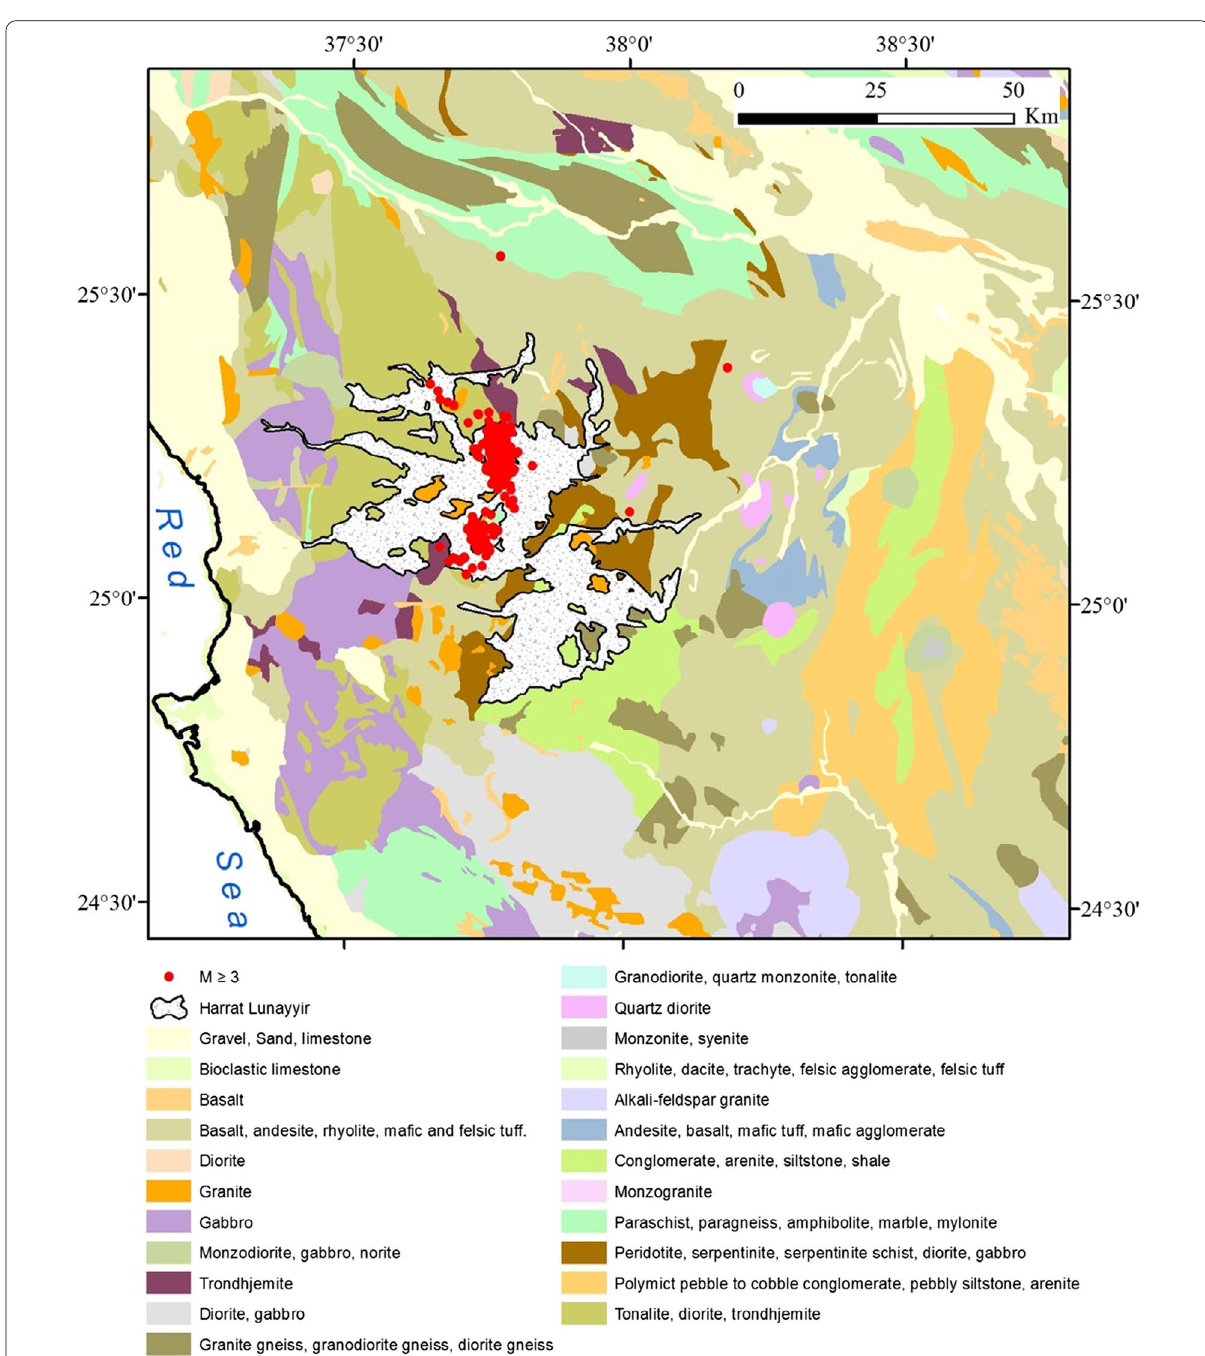
Fig. 2 Geological outline map for the Harrat Lunayyir (Mukhopadhyay et al., 2013) with epicenters of the 2009 seismic swarm shown by red